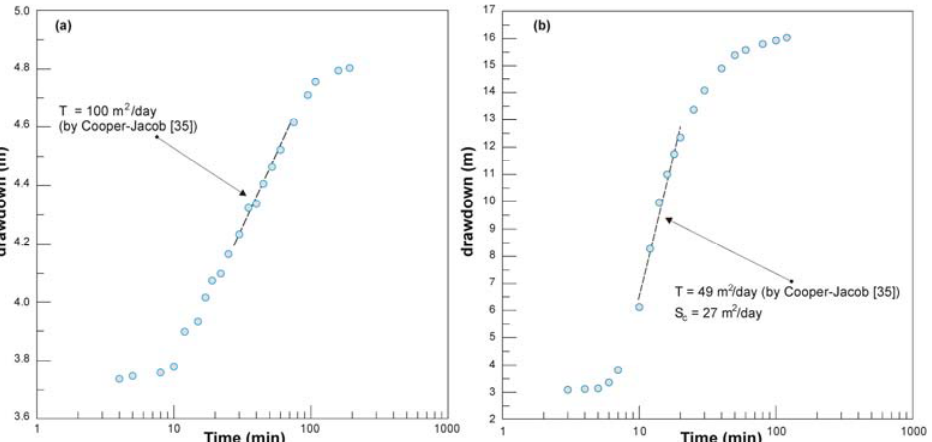
Figure 2. Cooper-Jacob straight-line method on two pumping tests carried out in Maiolica and Scaglia-Maiolica aquifers. ( a ) Drawdown data recorded in an observation well during the first step-drawdown pumping test in MCUC1 well. ( b ) Drawdown data recorded in SUB well (first step-drawdown curve at low discharge Q = 0.005 m 3 /s).